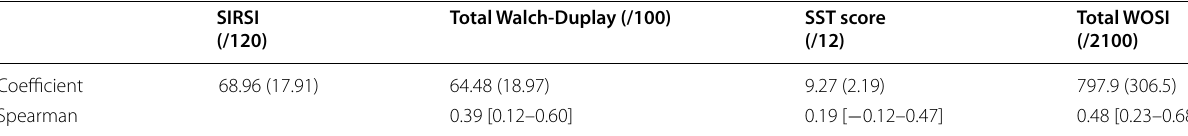
Table 2 correlation SIRSI and other scores